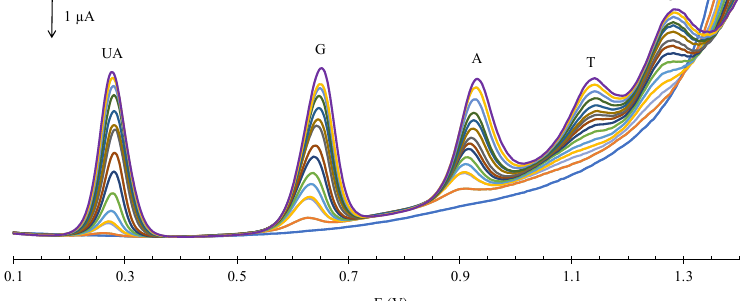
Figure 7. Calibration curves based on DPV for simultaneous detection of UA, G, A, T, and C using GCE/GO ‐ MWCNT ‐ CHT with concentrations ranging from 1.0–151.0, 1.0 ‐ 78.0, 1.0 ‐ 79.5, 5.0 ‐ 267.5, and 12.5–182.5 μ M for UA, G, A, T, and C, respectively. The lowest end of the dynamic ranges started from the blue curve and ended in the purple curve for the highest.